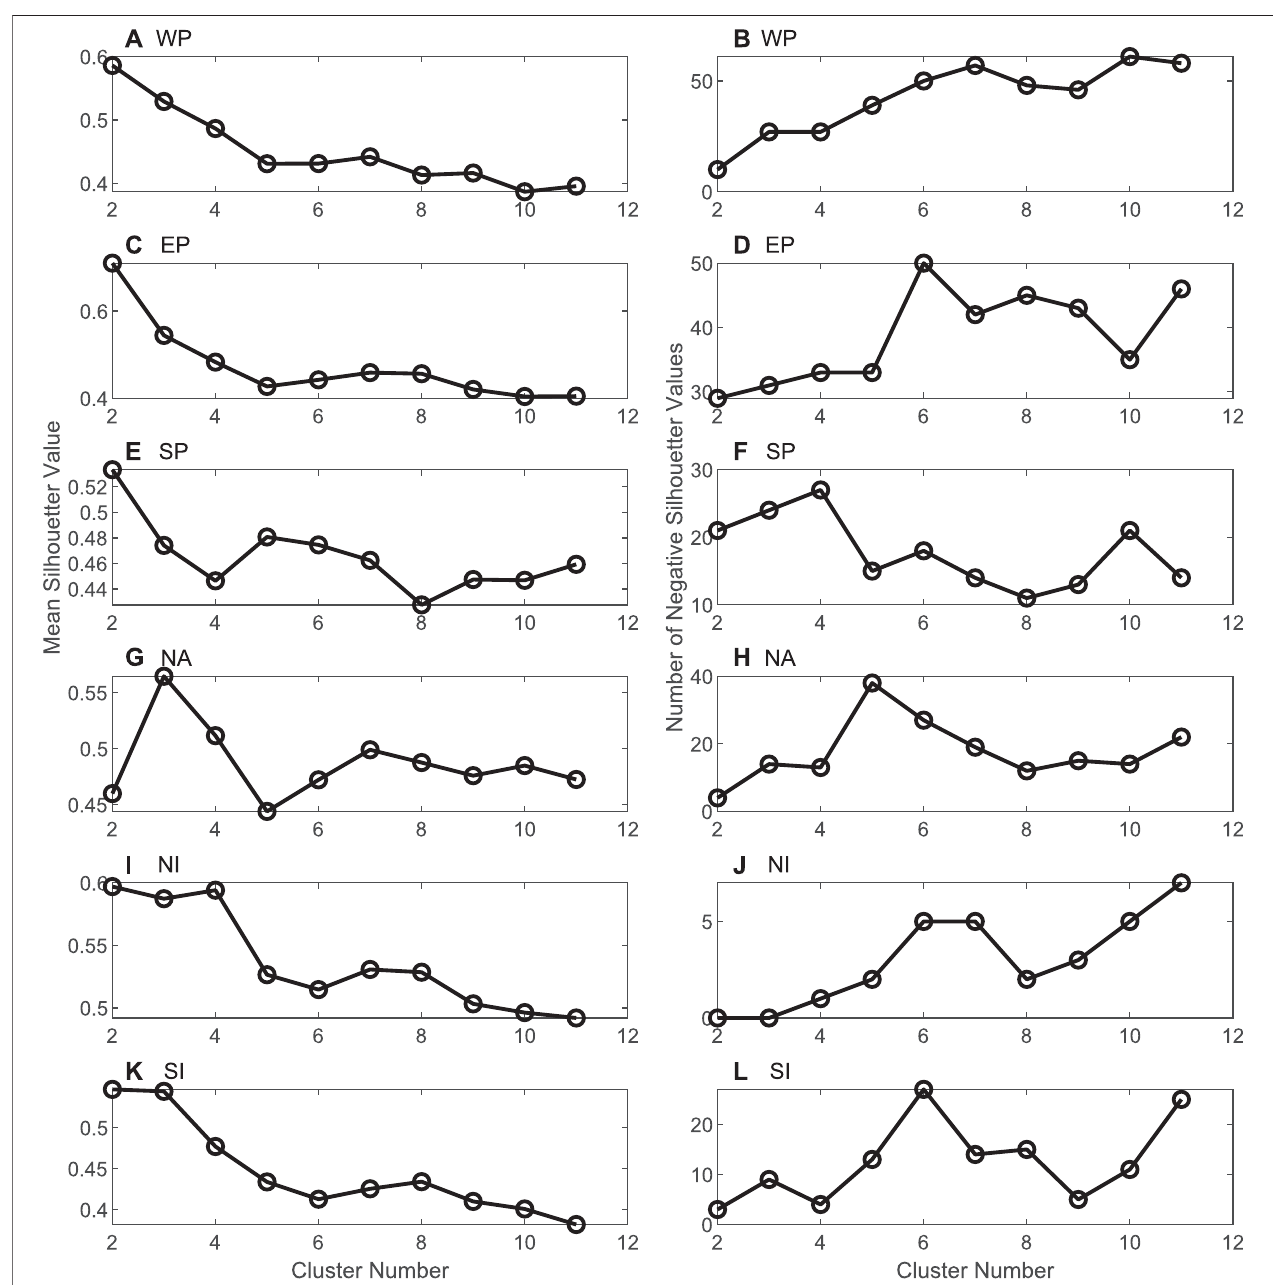
FIGURE2 | Changes inmeansilhouette values forobserved TCsindifferentareas (A,C,E,G,I, and K) , and the number ofnegativesilhouette values (B,D,F,H, and J) with the cluster number of TC track.